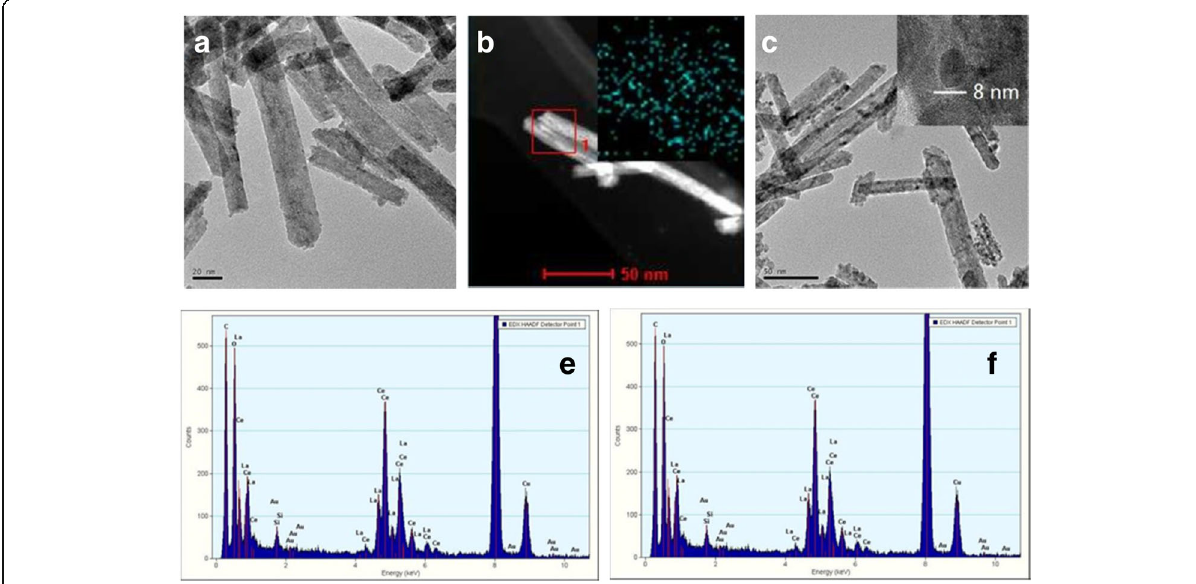
Fig. 5 TEM and STEM images of 0.5% Au/Ce 0.75 -La 0.25 nanorods calcined at 300 °C ( a – b ) and 400 °C ( c ), EDX analysis ( e – f ) of the images of ( a – b ) indicating the presence of Au